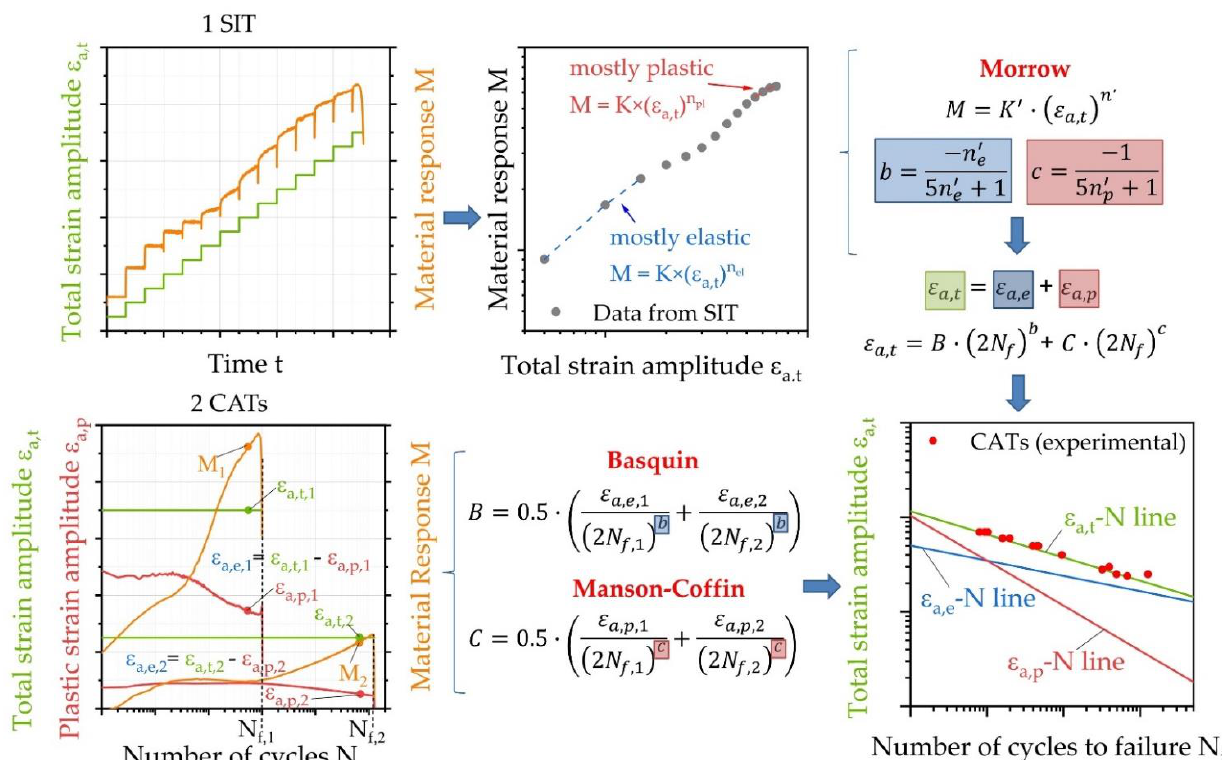
Figure 2. Schematic workflow for the fatigue life calculation method StrainLife.